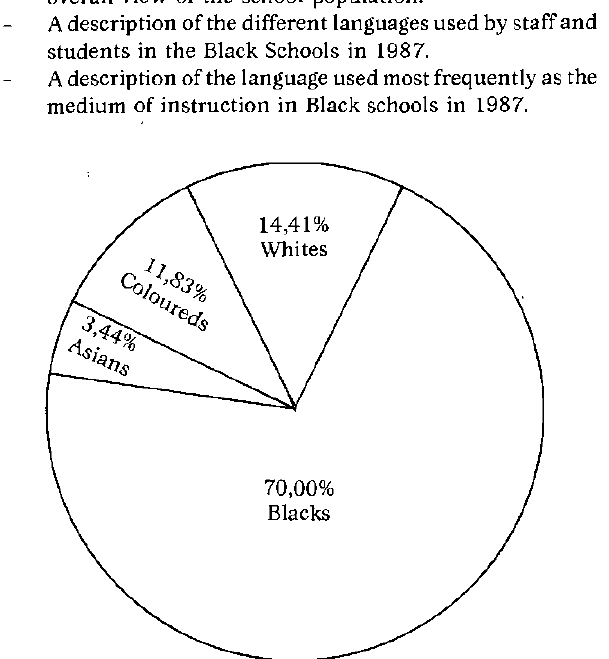
Figure 1: Pupils to population group for 1988 including self-governing states